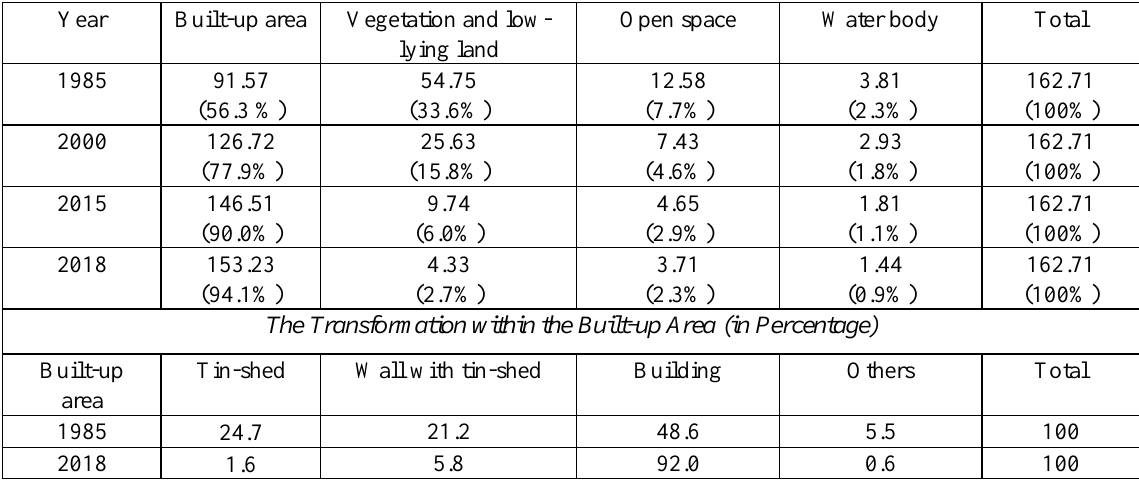
Table 1. The Transformation of Land, Nature and Physical Structures in Panthapath, 1985-2018 Year Built-up area Vegetation and low- Open space Water body Total lying land 1985 91.57 54.75 (56.3 %)